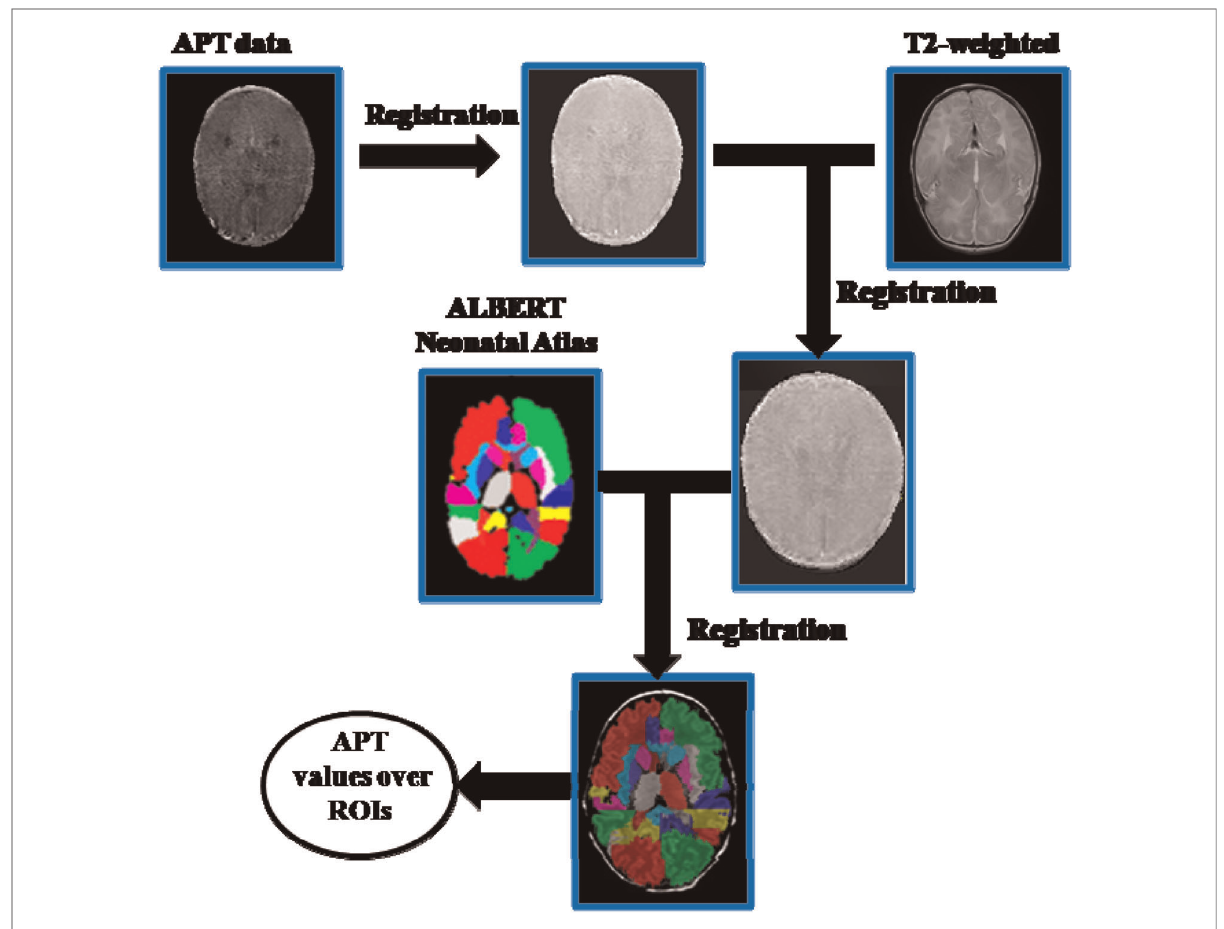
FIGURE 1 Flowchart of the APT data processing